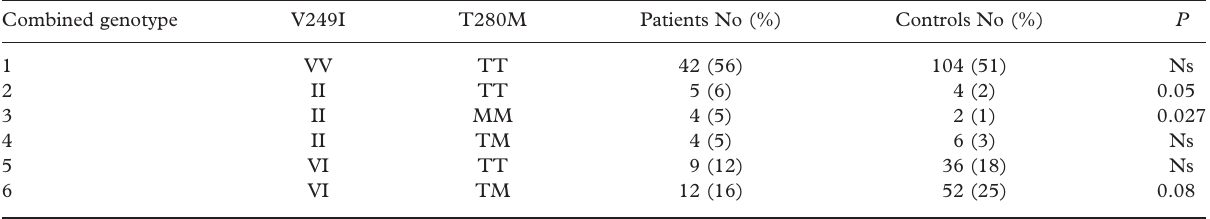
Global haplotype effect x 2 ¼ 12.85, p ¼